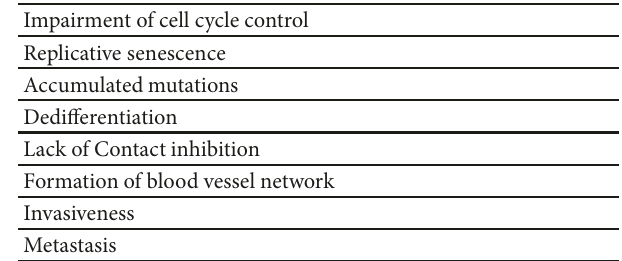
Table 1: Characteristics of cancer